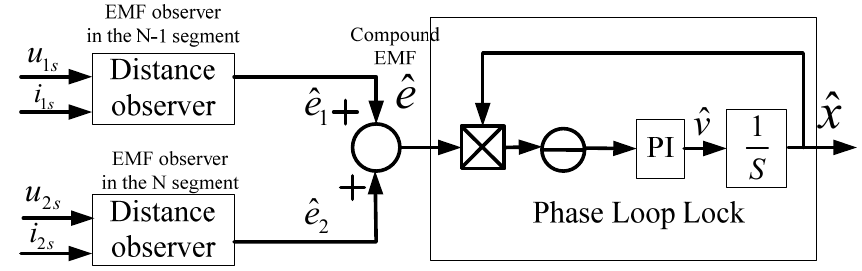
Figure 4. The mover estimation between segments.